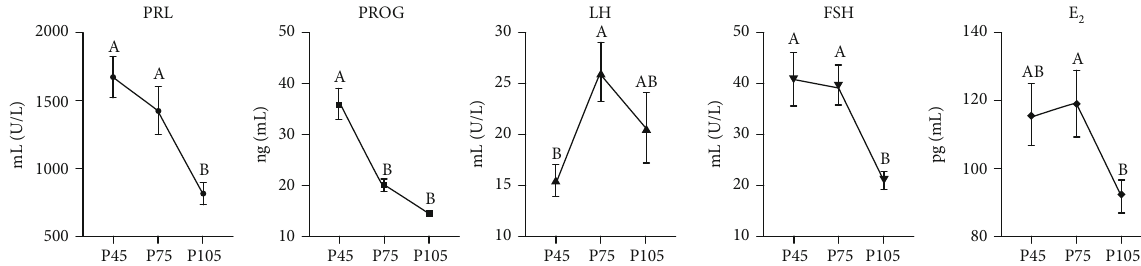
Figure 1: The changes of plasma reproductive hormone levels in sows at di ff erent stages of pregnancy. PRL: prolactin; PROG: progesterone; LH: luteinizing hormone; FSH: follicle-stimulating hormone; E : estradiol. P45, P75, and P105 mean days 45, 75, and 105 of pregnancy, 2 respectively. The same as below. Data show the means ± SEM . A,B indicates statistically signi fi cant di ff erences ( P < 0 : 05 ). n = 6 ‐ 8 per